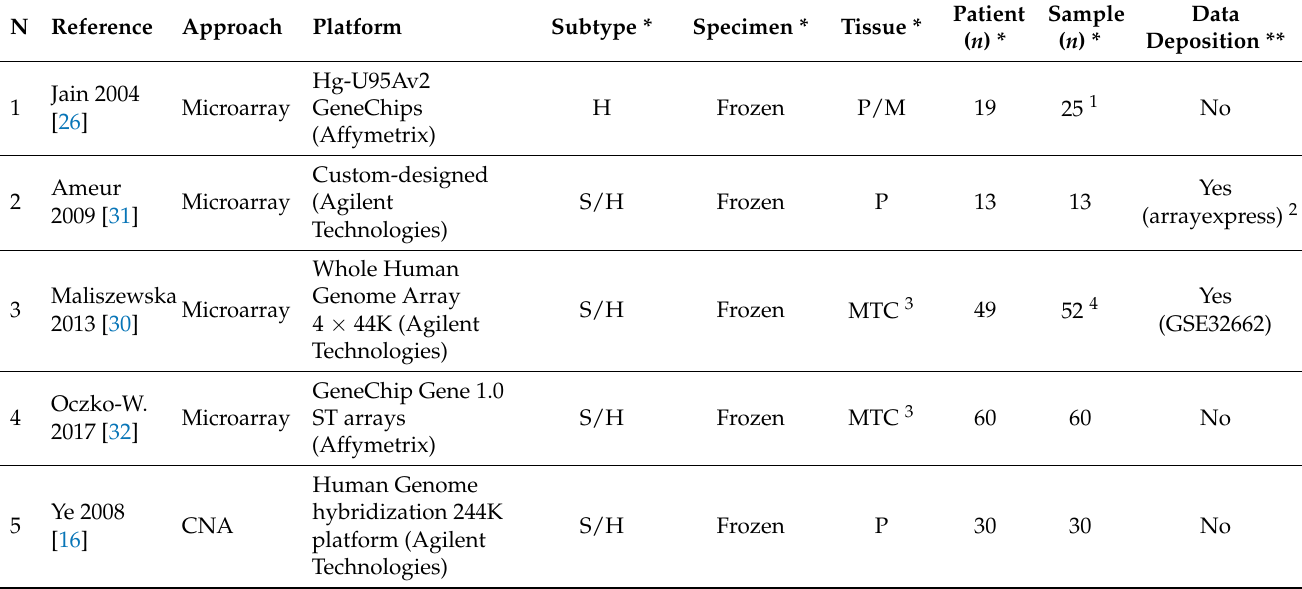
Table 1. List of studies investigating MTC patient cohorts with high-throughput